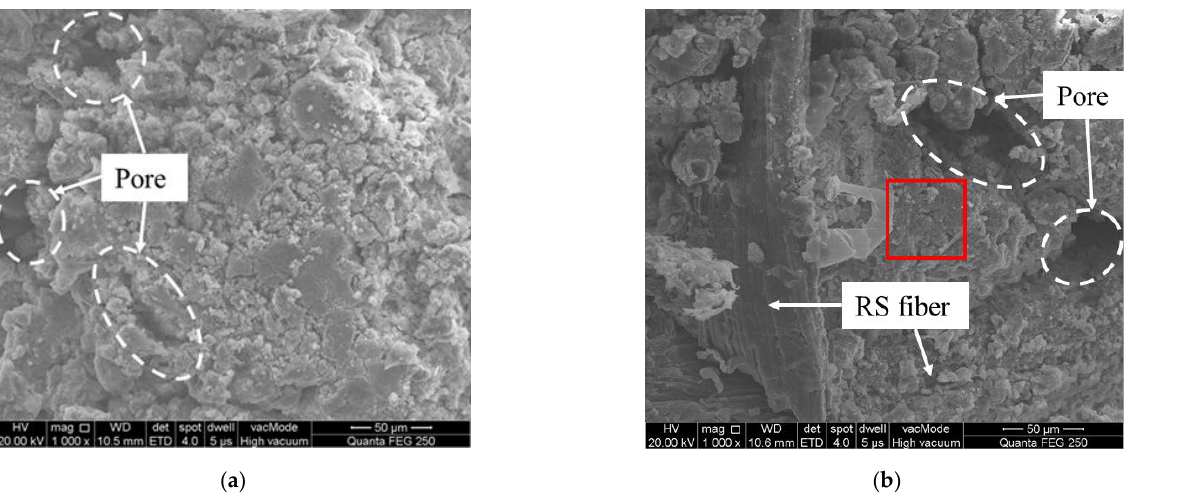
Figure 11. SEM images of A2 and A8 cured for 28 days. ( a ) A2; ( b ) A8.